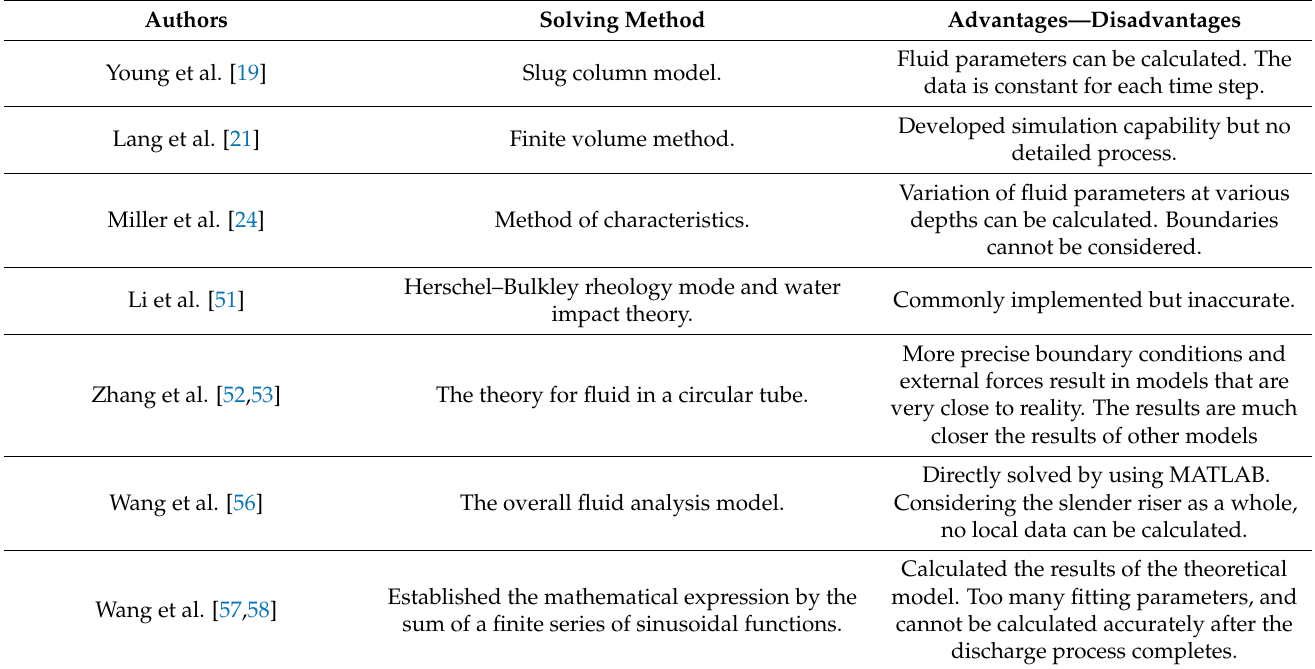
Table 2. The comparison of mud discharge